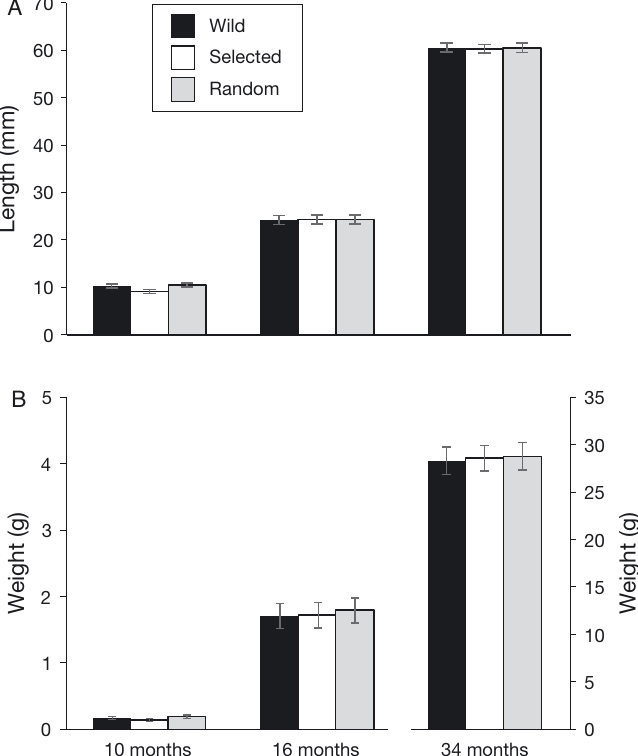
Fig. 2. (A) Length and (B) weight of abalone Haliotis tubercu- lata offspring at 10, 16 and 34 months of age from 3 different broodstock origins (wild, farmed selected for weight and farmed randomly sampled); n = 300 abalone treatment −1 at 10 mo, n = 264 abalone minimum treatment −1 at 16 mo, n = 63 minimum treatment −1 for length and weight at 34 mo. Mixed model unless otherwise stated (least square means ± SE). Note different scale for weight at 34